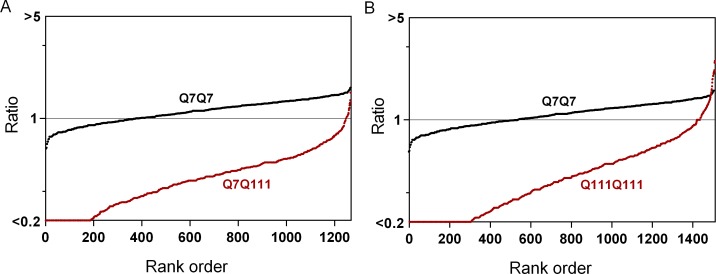
Summary plots of the peptidome of Q7Q7, Q7Q111 and Q111Q111 cells.The relative levels of all peptides identified by MS/MS analysis in the Q7Q111 (A) and Q111Q111 (B) cells were compared to the average level of the peptide in Q7Q7 cells. The y-axis represents relative peptide levels (log-scale) and the x-axis represents the rank order of peptides sorted according to the relative level. For those peptides detected multiple times (different charge states and/or tag numbers), the relative ratio for each form was considered separately. If the ratio was <0.20, the value was capped at 0.20 to reflect the typical signal to noise ratio. The red circles represent the ratio of each replicate of the identified peptides in Q7Q111 or Q111Q111 cells, expressed relative to the level in Q7Q7 cells for that LC-MS run. The black circles represent the ratio of each Q7Q7 replicate expressed relative to the average level of Q7Q7 replicates in that LC-MS run (i.e. run 1 and 2; the other two runs did not include replicates of Q7Q7 cells).